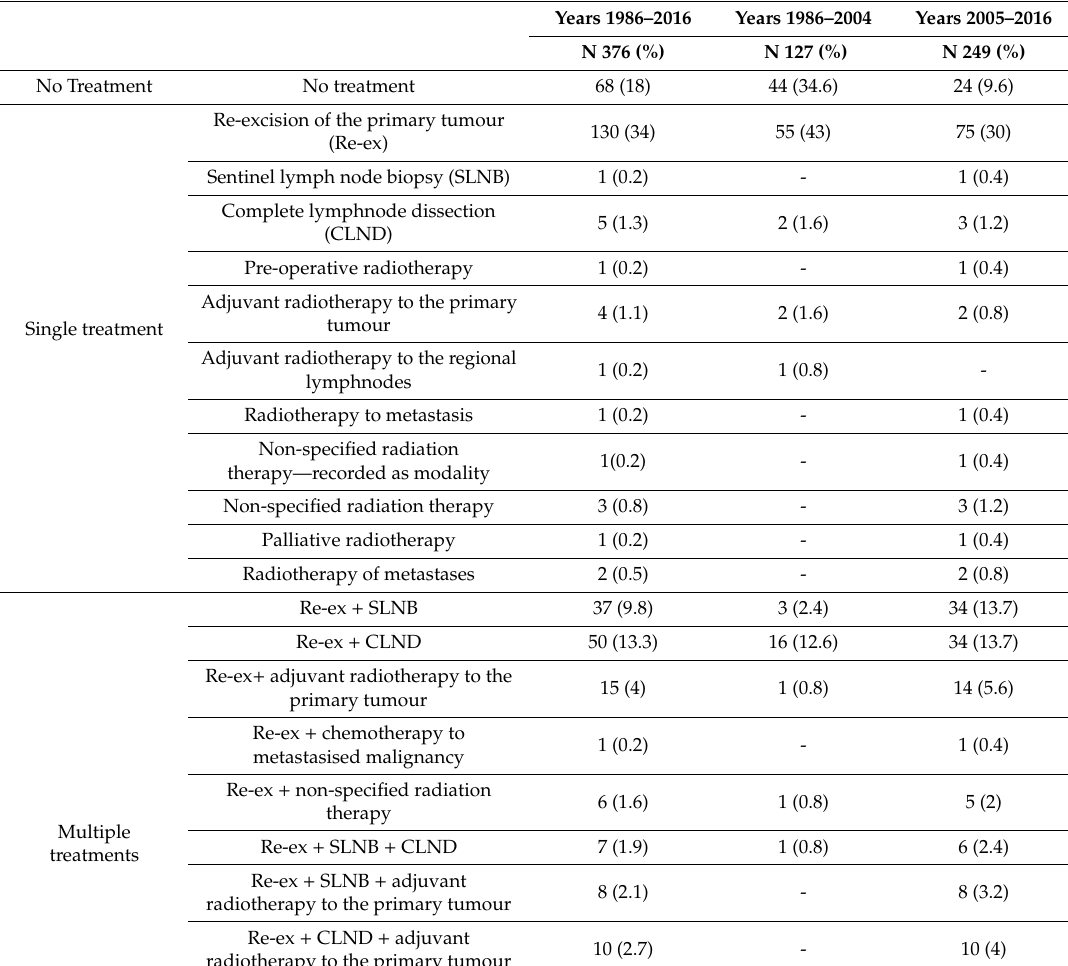
Table 2. Di ff erent treatments and treatment combinations recorded in the